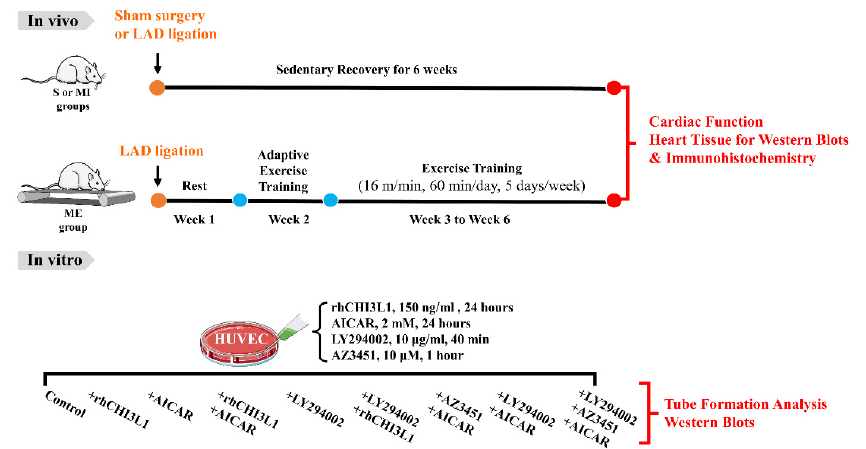
Figure 1. Schematic description of the study protocols in adult male rats involving induction of myocardial infarction (MI) through permanent ligation of left anterior descending coronary artery and post-MI exercise training that were carried out one week after the MI surgery and lasted five weeks, i.e., one-week adaptive exercise followed by aerobic exercise training sessions for additional four weeks. A parallel series of in vitro study in human umbilical vein endothelial cells (HUVEC) was also performed under the illustrated treatment